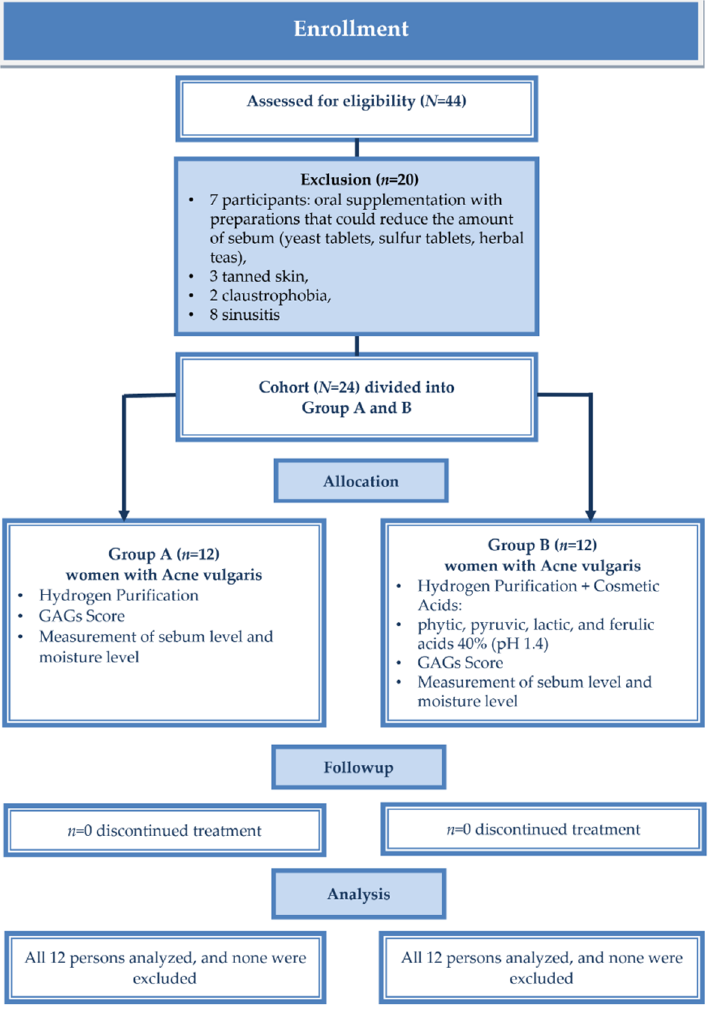
Figure 1. Patients follow in the study.